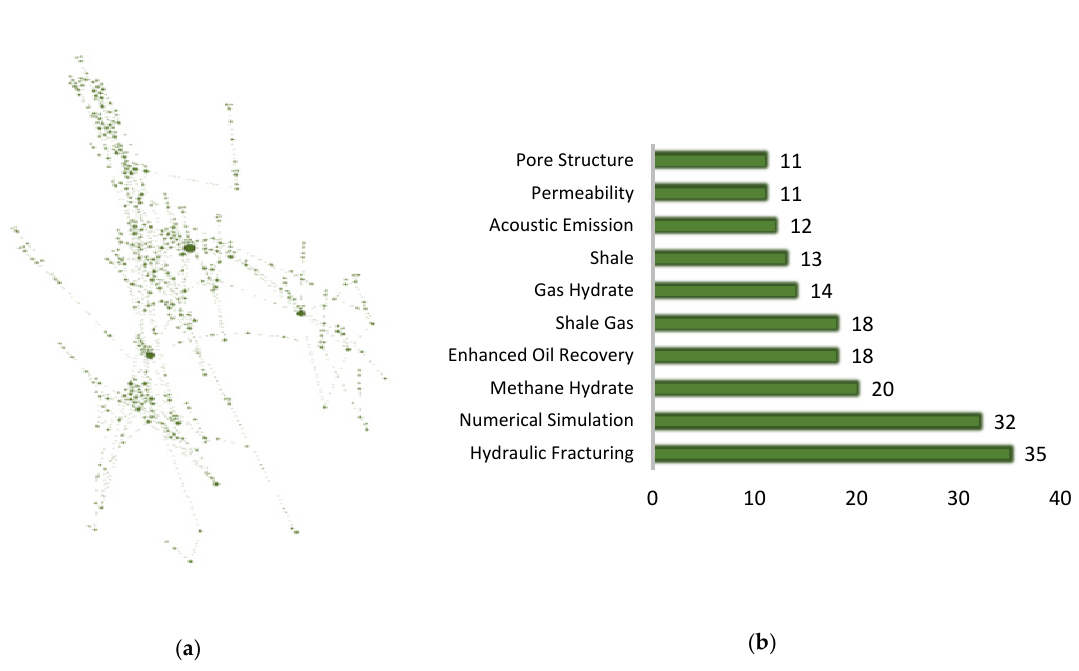
Figure 20. Hydrocarbon improvements: ( a ) manuscripts published, ( b ) keywords.